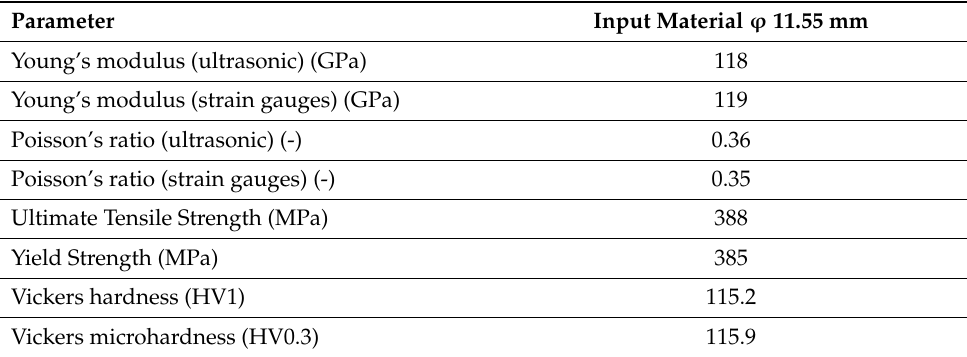
Table 3. Mechanical and elastic properties of the input